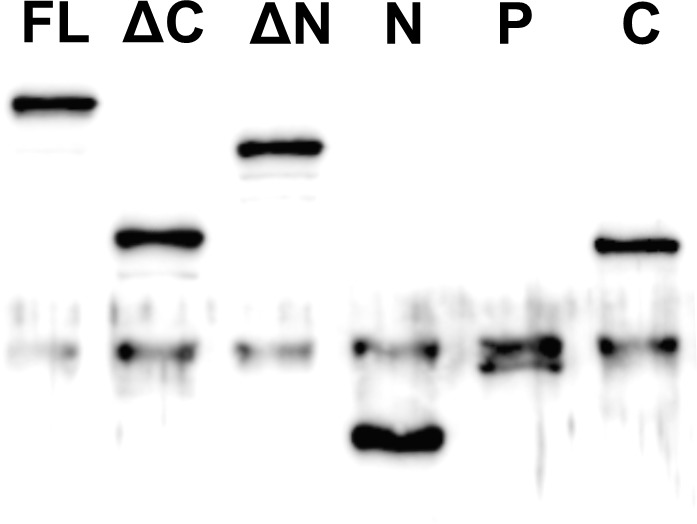
Western blot analysis of EGFP fusion proteins of MAP7-FL and various domain fragments expressed in COS cells.